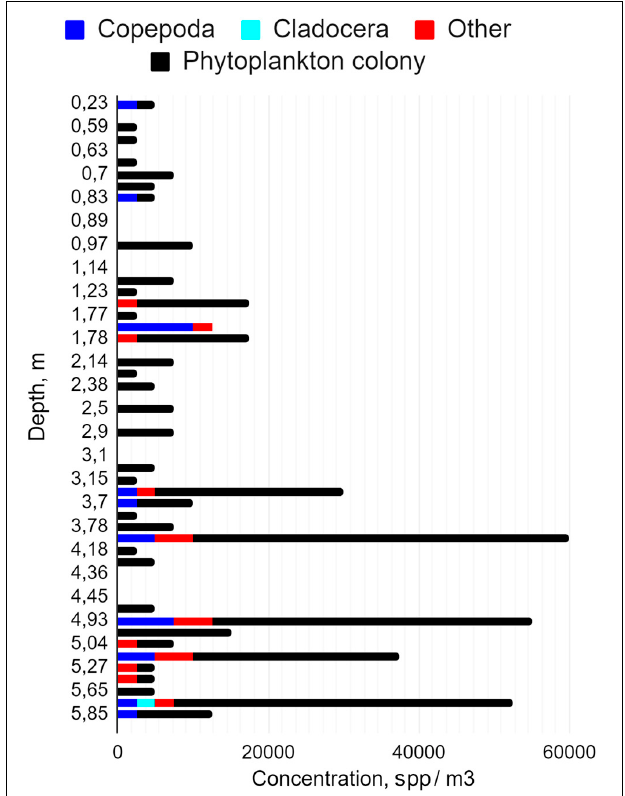
FIGURE 3 | Distribution profile of plankton concentrations of various taxa in depth up to 6 m. The following taxa are present: Copepoda (blue), Cladocera (turquoise), other (red), and phytoplankton colony